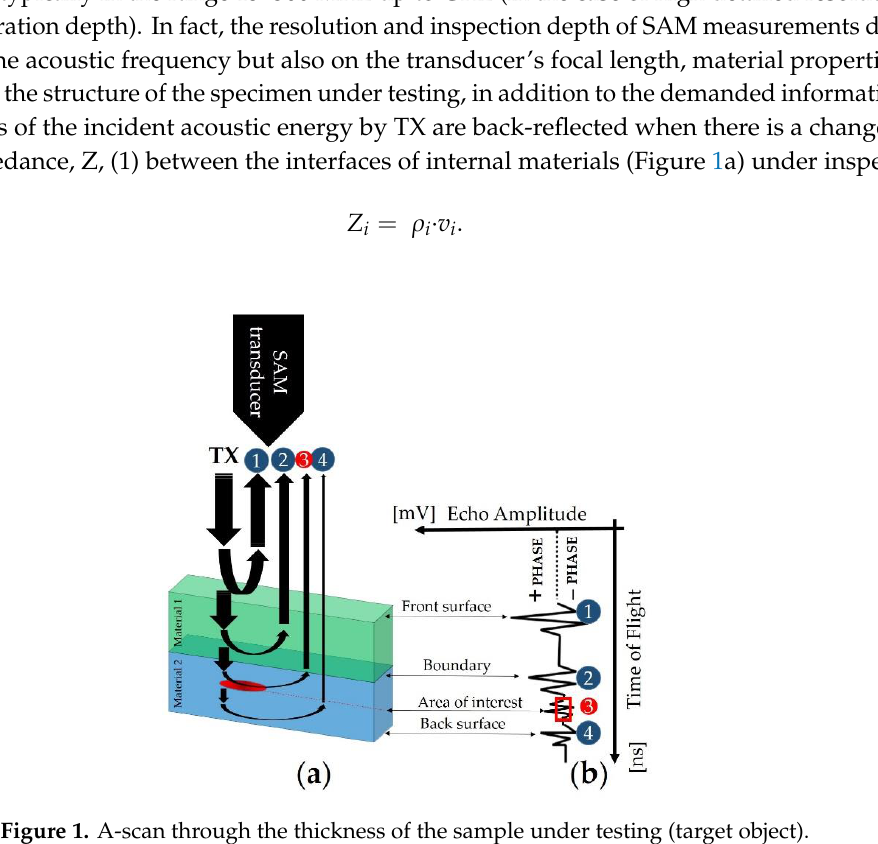
Figure 1 . A-scan through the thickness of the sample under testing (target object). Figure 1. A-scan through the thickness of the sample under testing (target